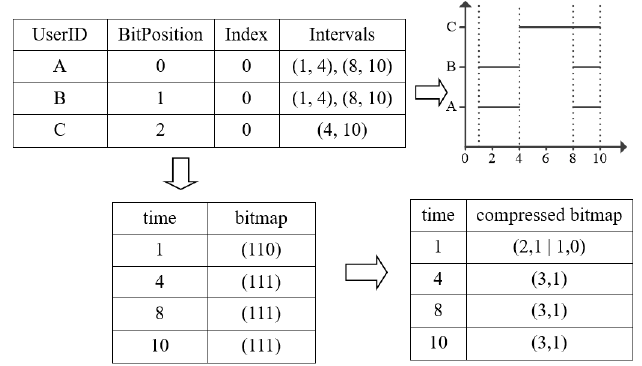
Figure 2. Bitmap Index Construction Example.